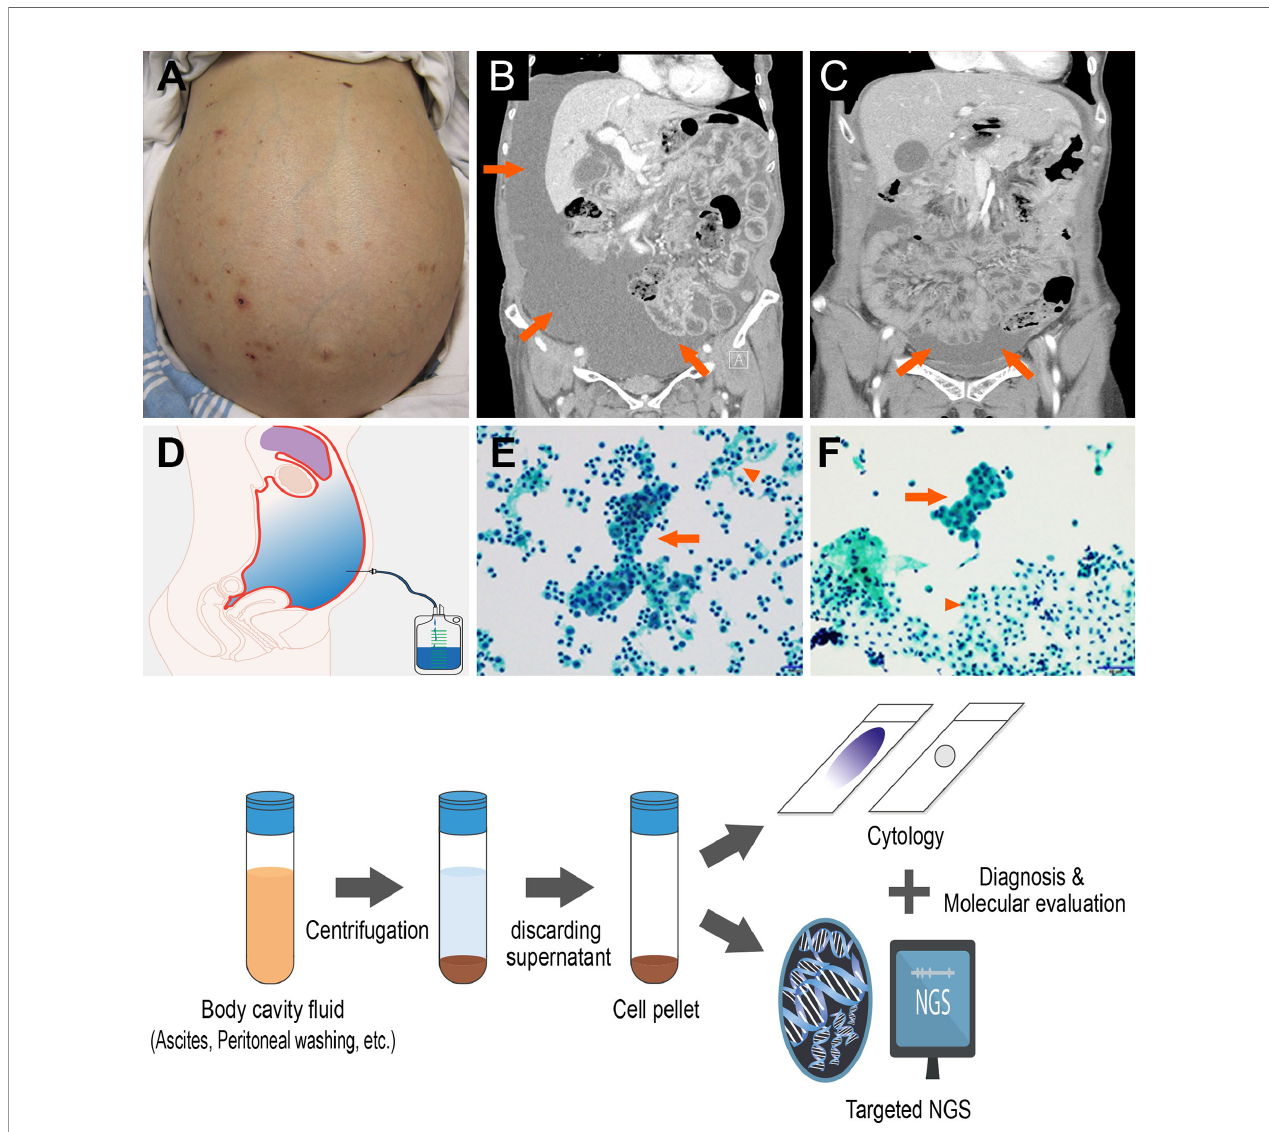
FIGURE 1 | Ascites and peritoneal washing cytology from the gastrointestinal cancer patients (A) Patients with swollen abdomen with massive ascites. Abdominal computed tomography scans showing (B) a large amount of ascites, (C) mild ascites irrigated with peritoneal washing. (D) Cytology samples can be collected from paracentesis. (E) Ascites and (F) peritoneal washing cytology contains tumor cells (arrow) with abundant background mesothelial cells and in fl ammation cells (arrow head). (Below) Cytology sample processing to diagnosis and targeted